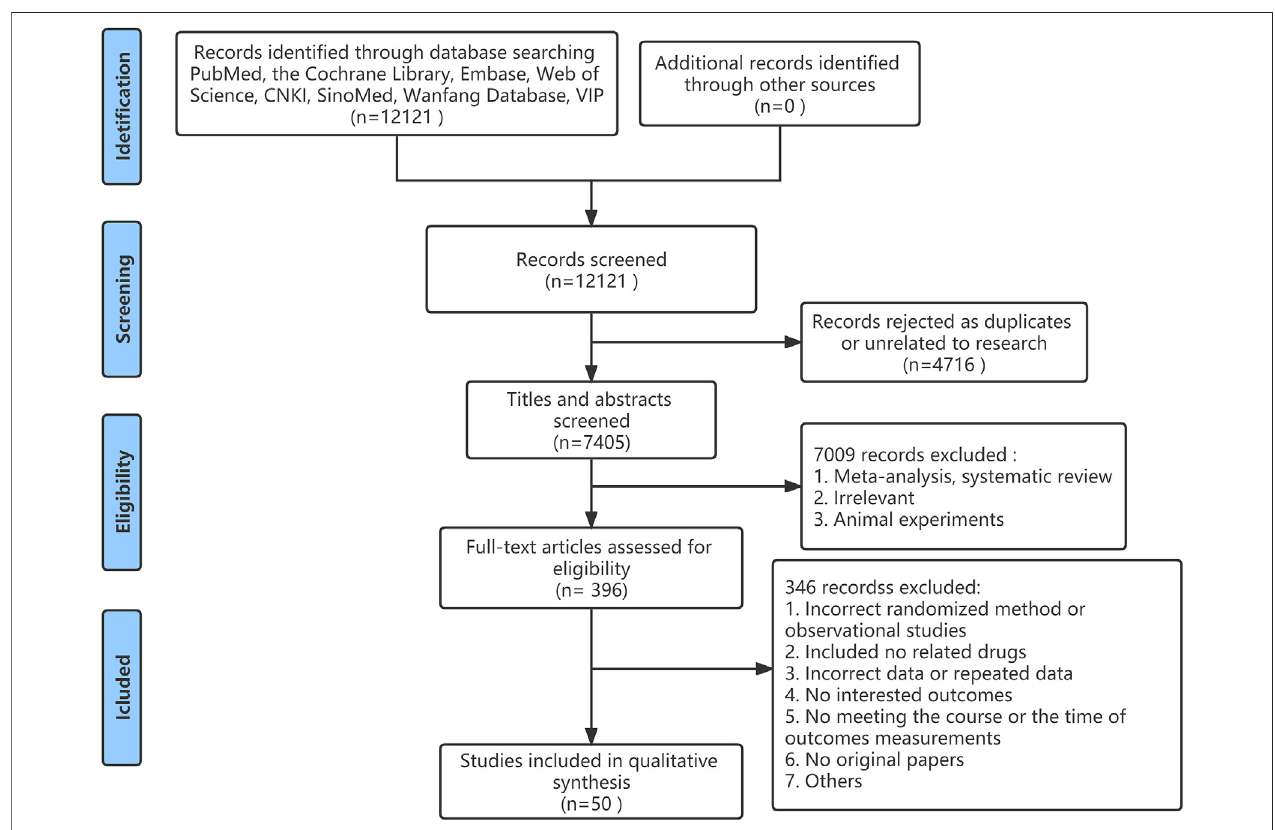
FIGURE 1 | Flow diagram of study